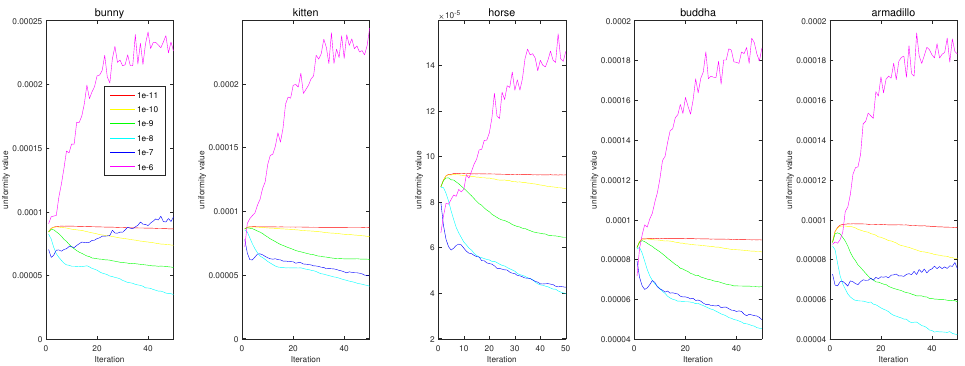
Figure 21. Quantitative performance of the proposed method for various β . The horizontal axis indicates the iteration, and the vertical axis indicates the uniformity value. Each column represents a different input point cloud (first column: Horse, second column: Bunny, third column: Kitten, fourth column: Buddha, and fifth column: